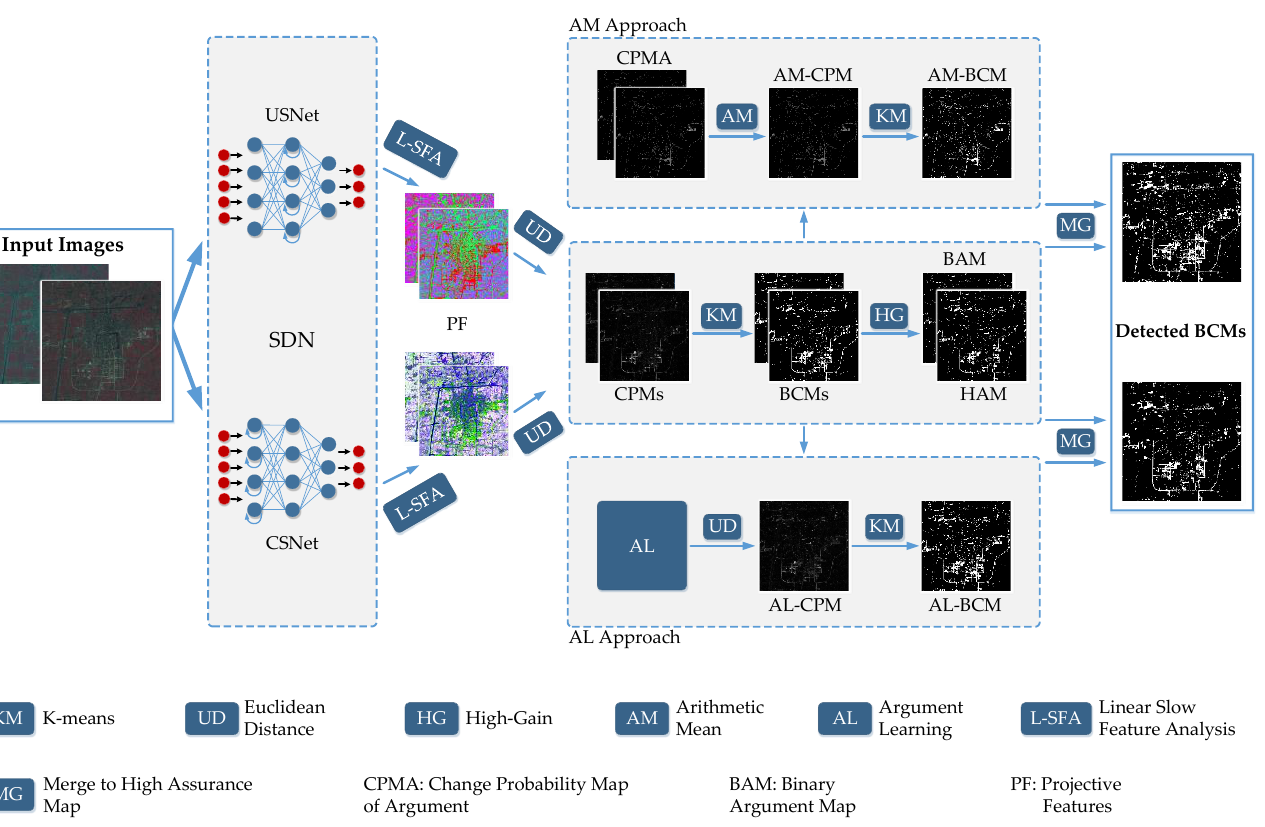
KP=0.8 Figure 2. Architecture of the proposed SDN. ( a ) FCN; ( b ) USNet; and ( c ) CSNet.